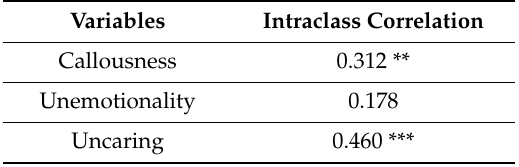
Table 2. Adolescent–parent agreement ratings on callous–unemotional (CU) traits n =